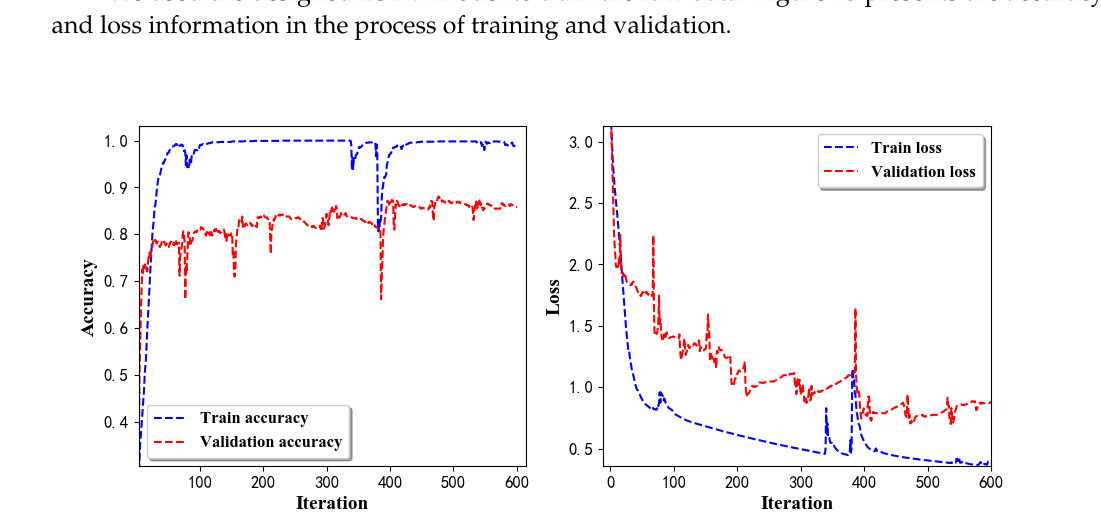
Figure 13. Accuracy ( left ) and loss ( right ) information of training and validation